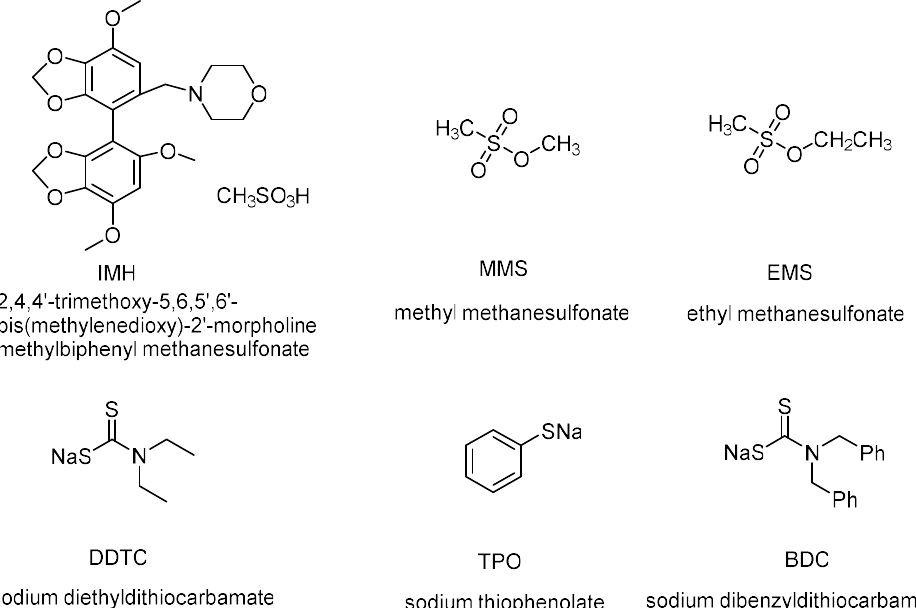
Table 1. A comparison of the derivatization reagents. Derivatization